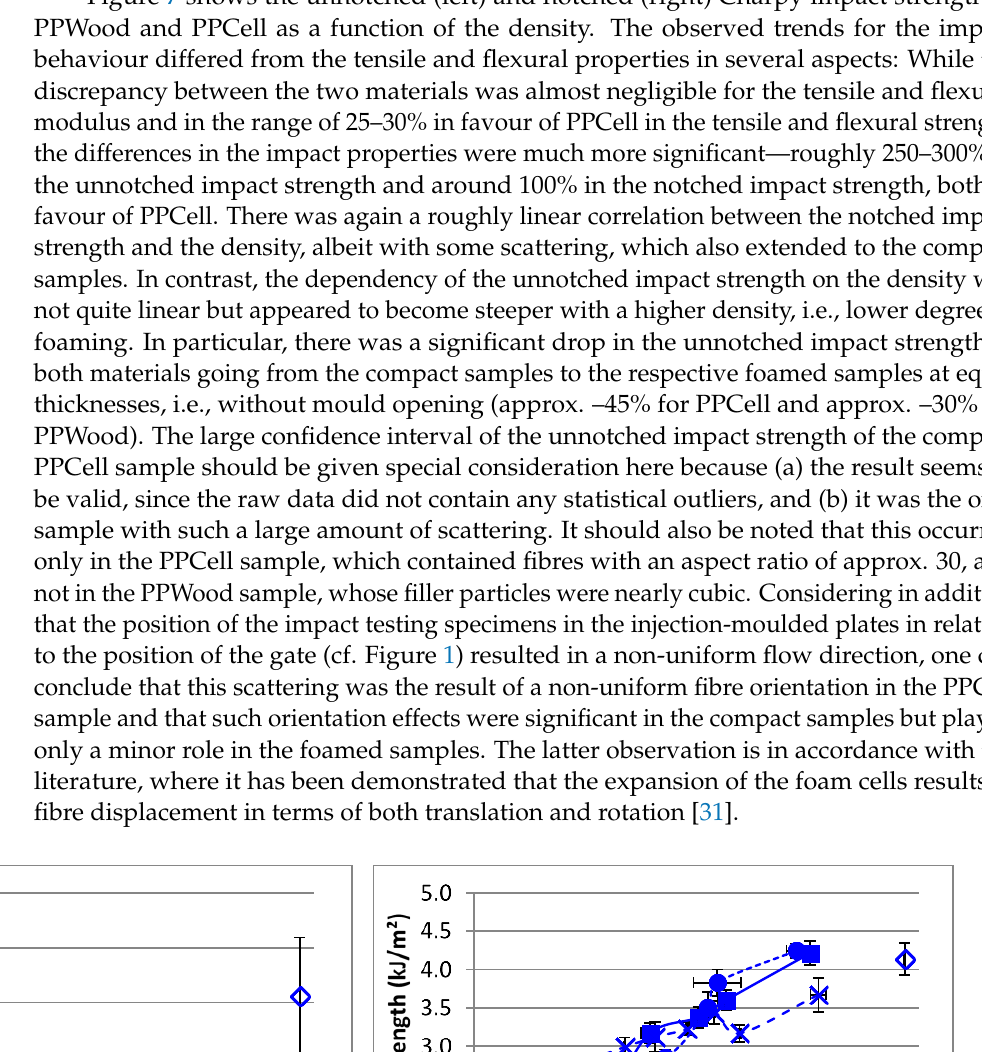
Figure 6. Dependence of the flexural modulus ( left ) and flexural strength ( right ) on the density of the foamed parts. Legend: PPCell, PPWood. Compact samples— ; samples N03_T60— , dashed line; samples N06_T60— , solid lines; samples N06_T40— , dotted lines. Error bars show 95% confidence interval. If not visible, error bars lie within the size of the used symbol for the respective sample. Impact Properties Figure 7 shows the unnotched (left) and notched (right) Charpy impact strength of PPWood and PPCell as a function of the density. The observed trends for the impact be- haviour differed from the tensile and flexural properties in several aspects: While the dis- crepancy between the two materials was almost negligible for the tensile and flexural modulus and in the range of 25–30% in favour of PPCell in the tensile and flexural strength, the differences in the impact properties were much more significant—roughly 250–300% in the unnotched impact strength and around 100% in the notched impact strength, both in favour of PPCell. There was again a roughly linear correlation between